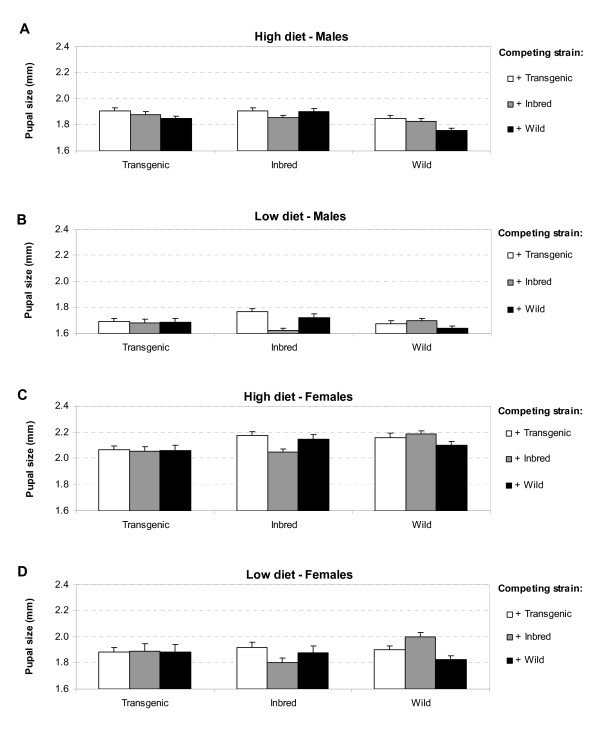
Least squares means (±SE) of pupal size (cephalothorax length) of Ae. aegypti. (A) Pupal size of males at high diet levels, (B) of males at low diet levels, (C) of females at high diet levels and (D) of females at low diet levels. Each bar represents one treatment combination consisting of strain and presence of competing strain.